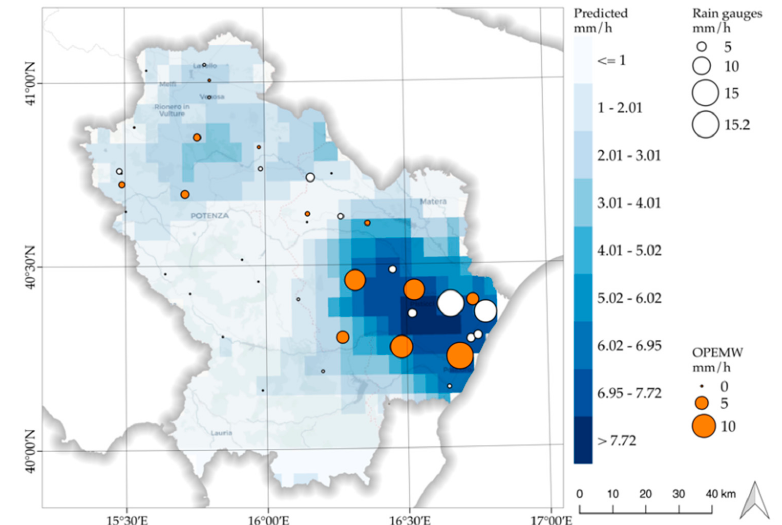
Figure 4. Comparisons between rain gauge observations, the original OPEMW SRI and downscaled data for the date 12 Jan 2018 at 06:54 a.m. UTC. The white circles represent the SRI measured by rain gauges and the orange circles represent the OPEMW SRI. The symbol size represents the SRI in mm/h.